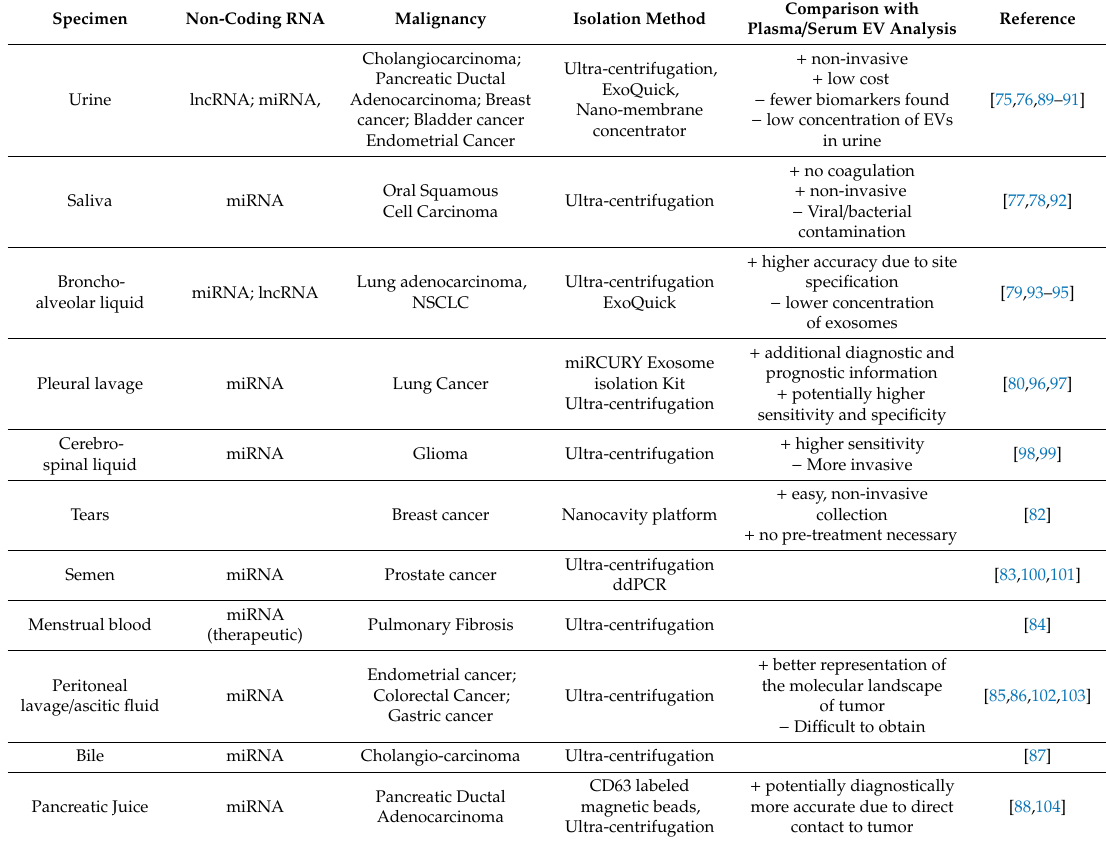
Table 1. Overview of specimen-derived extracellular vesicles (EVs) for cargo